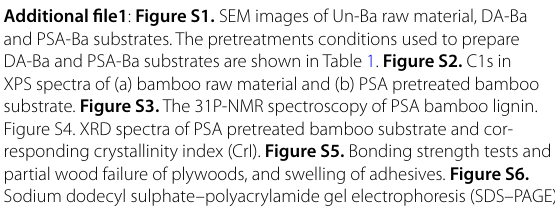
substrate. Figure S3. The 31P-NMR spectroscopy of PSA bamboo lignin. Figure S4. XRD spectra of PSA pretreated bamboo substrate and cor- responding crystallinity index (CrI). Figure S5. Bonding strength tests and partial wood failure of plywoods, and swelling of adhesives. Figure S6. Sodium dodecyl sulphate–polyacrylamide gel electrophoresis